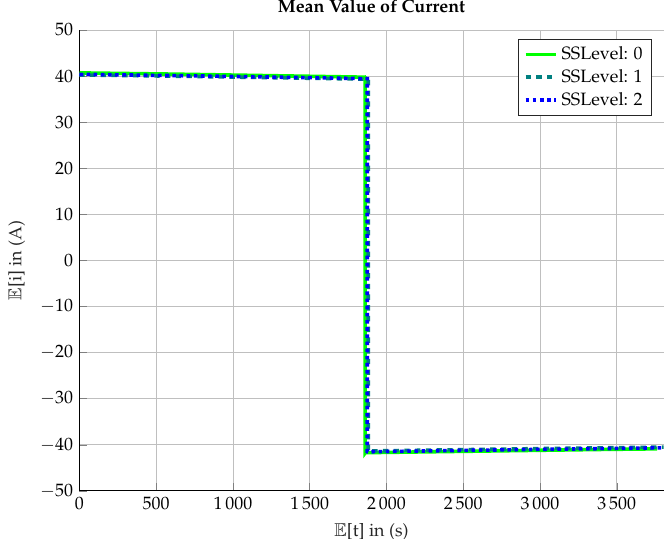
Figure 8. Robust control history for the current as the command variable over time for charge–discharge cycle.